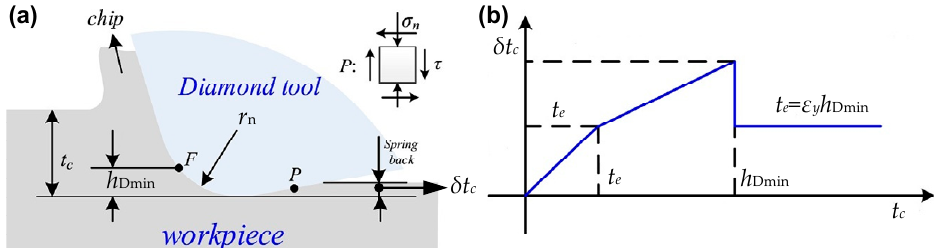
Figure 5. Piecewise function for the distribution of material spring back component in one feed rate: ( a ) illustration for the material spring back in diamond turning process; ( b ) three-section piecewise function form proposed by Zhu et al . Reproduced with permission from [55].